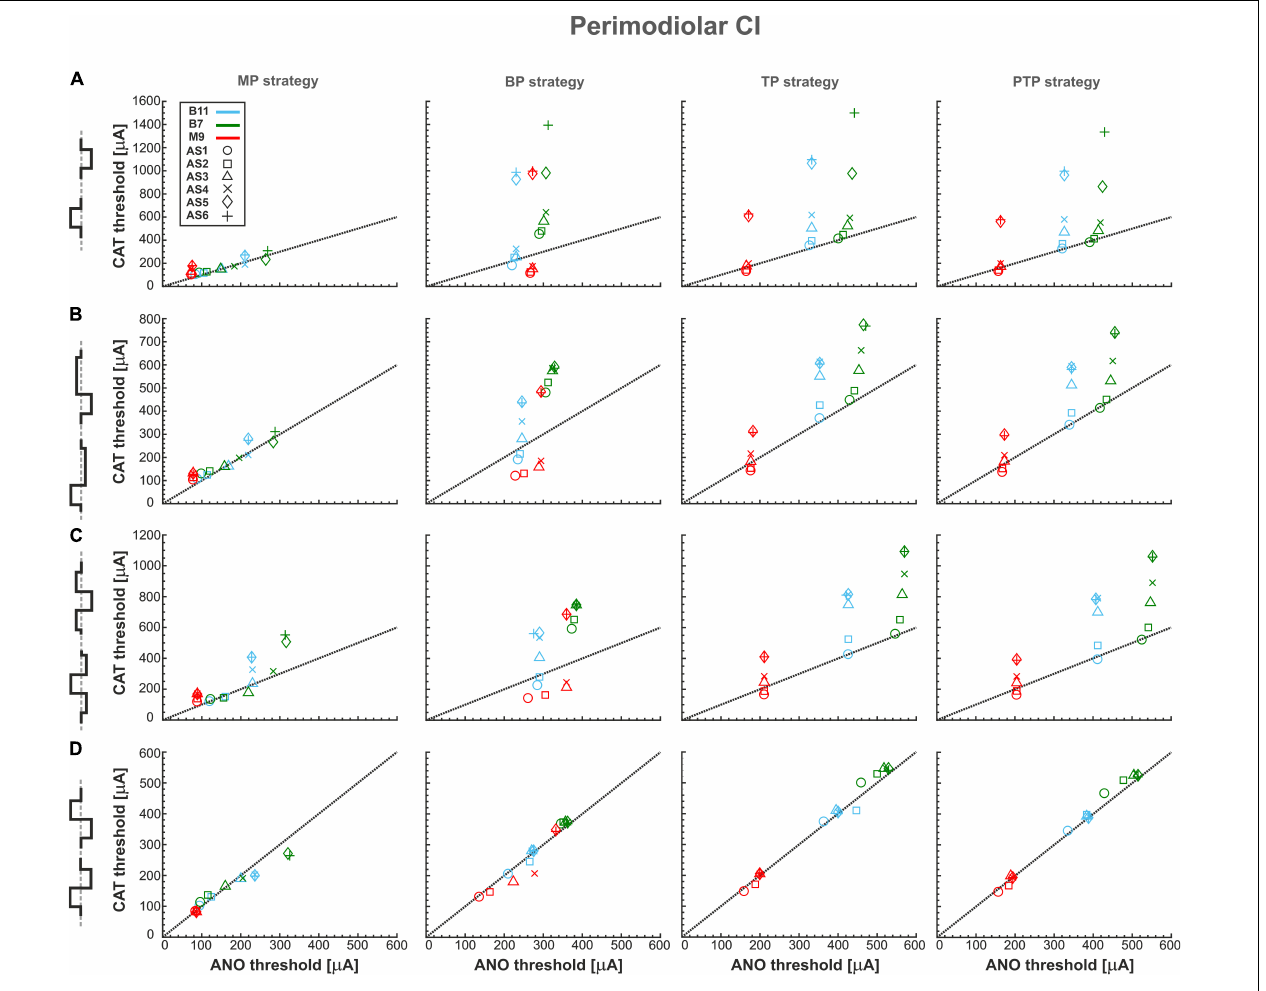
FIGURE 4 | Threshold profiles of three TNs for perimodiolar CI. Thresholds are shown for four stimulation configurations: MP, BP, TP, and PTP with (A) monophasic, (B) pseudomonophasic, (C) triphasic, and (D) biphasic pulse. Blue, green, and red colors represent B11, B7, and M9, respectively, in all panels. ANF status based on degeneration levels is indicated with circle, rectangle, triangle, cross, diamond, and plus shapes for AS1, AS2, AS3, AS4, AS5, and AS6, respectively. Black dotted lines represent the ANO/CAT = 1. Legend from top-left panel A applies to all